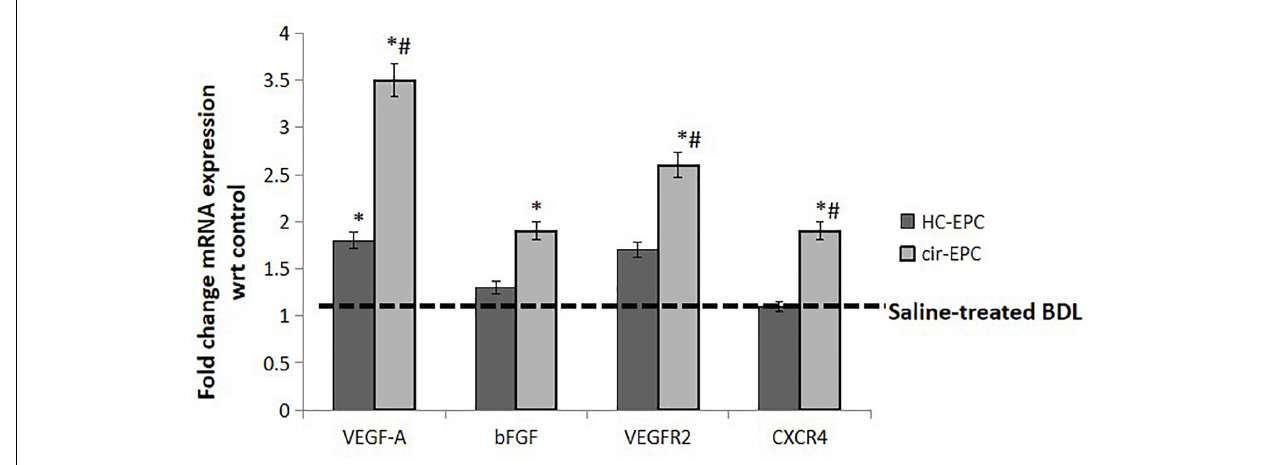
FIGURE 7 | mRNA expression of genes in liver tissue samples of healthy and cirrhotic EPC-transplanted rats. Dotted line represents control showing gene expression in Huh7 cells treated with BSA. Data represent mean ± SD, ( n = 4). * P < 0.05 vs. saline, # P < 0.05 vs. healthy EPC-treated